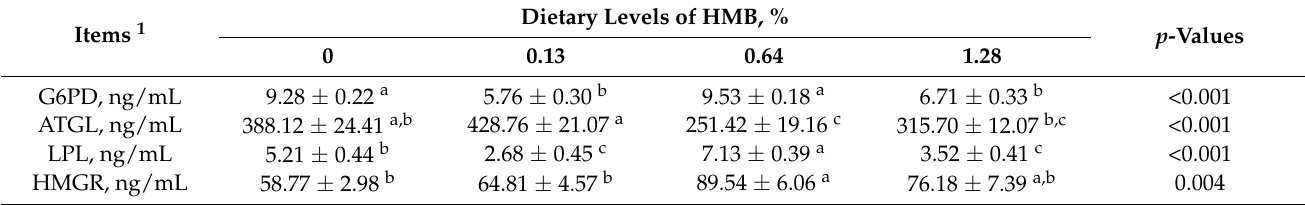
Table 3. Serum lipid-related substances of Bama Xiang mini-pigs fed the diets with various levels of HMB ( n = 8). Items